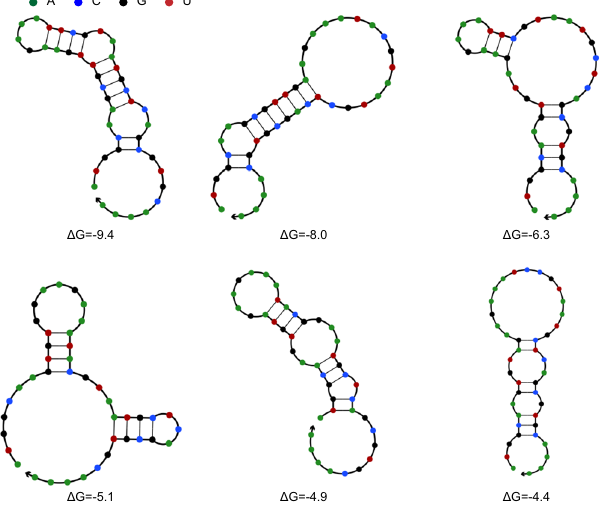
Figure 6. Predicted mRNA secondary structures of the 5 ′ region of different variant STS. The figure exhibited the secondary structure of the region ranged from nt + 1 to nt + 42. Numbers such as − 9.4, − 8.0 meant Δ G (kcal/mol) of the 5 ′ region of mRNA secondary structure. Δ G of original STS was − 9.4